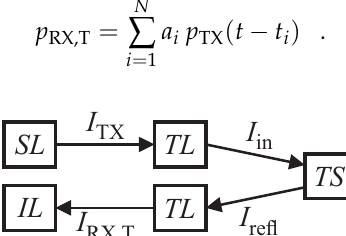
Figure 6. Acoustic intensities along transmission path; SL source level, I TX transmitter intensity, TL transmission loss, I in target input intensity, TS target strength, I refl reflected target intensity, I RX,T input intensity from target and IL input